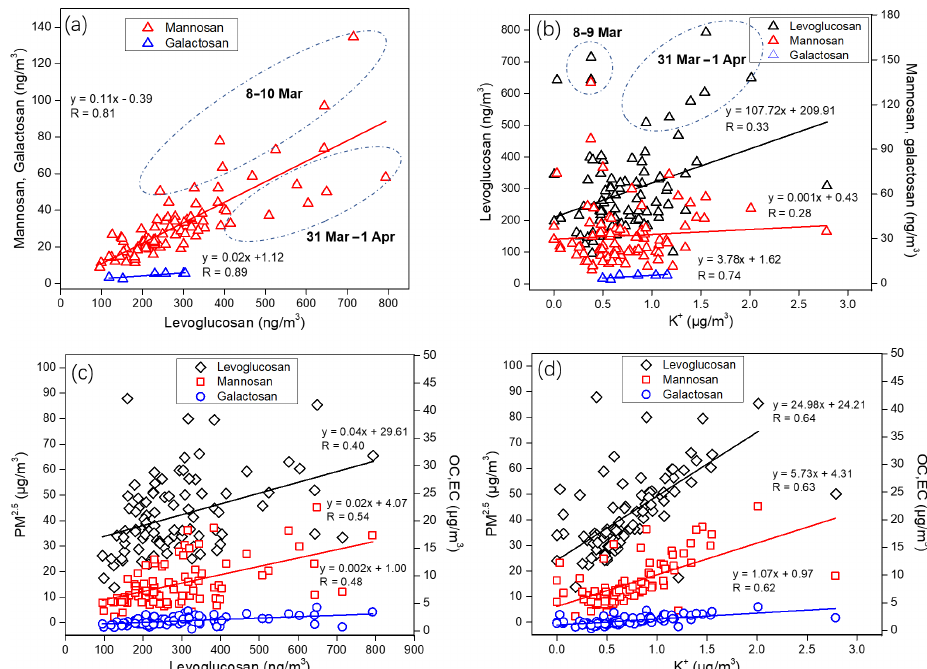
Figure 3. (a) Regression analyses of levoglucosan versus the other two anhydrosugars; (b) K + versus the other three anhydrosugars; (c) lev- oglucosan versus PM 2 . 5 , OC, and EC; and (d) K + versus PM 2 . 5 , OC, and EC.